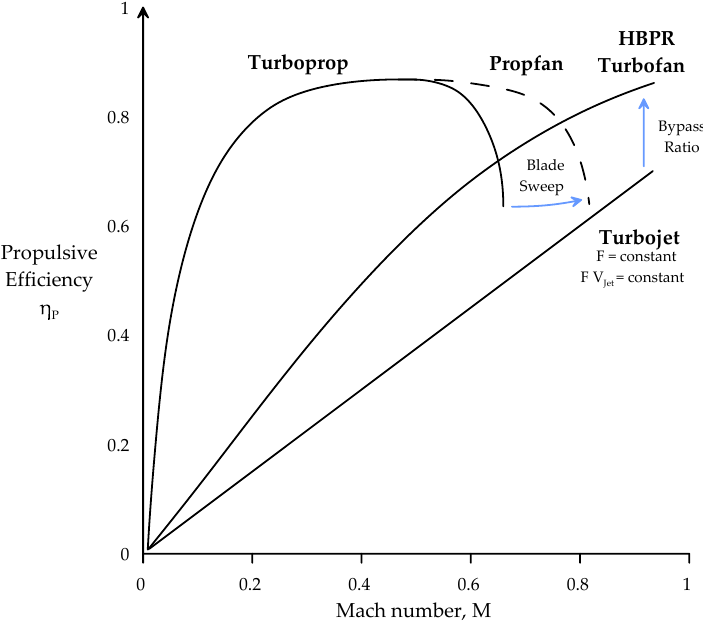
Figure 3. Propulsive efficiency for different engine